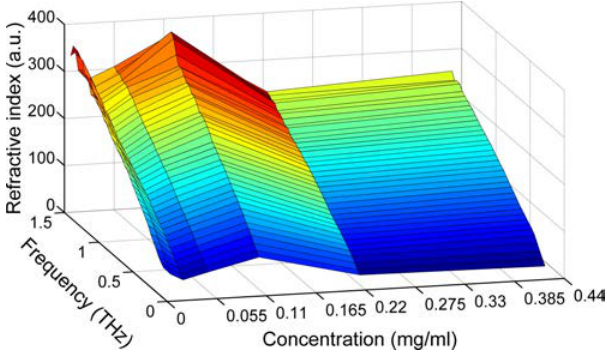
Fig. 5. Di®erence in the T-rays absorption coe±cient against HA protein concentration from 0.15 to 1.50 THz.